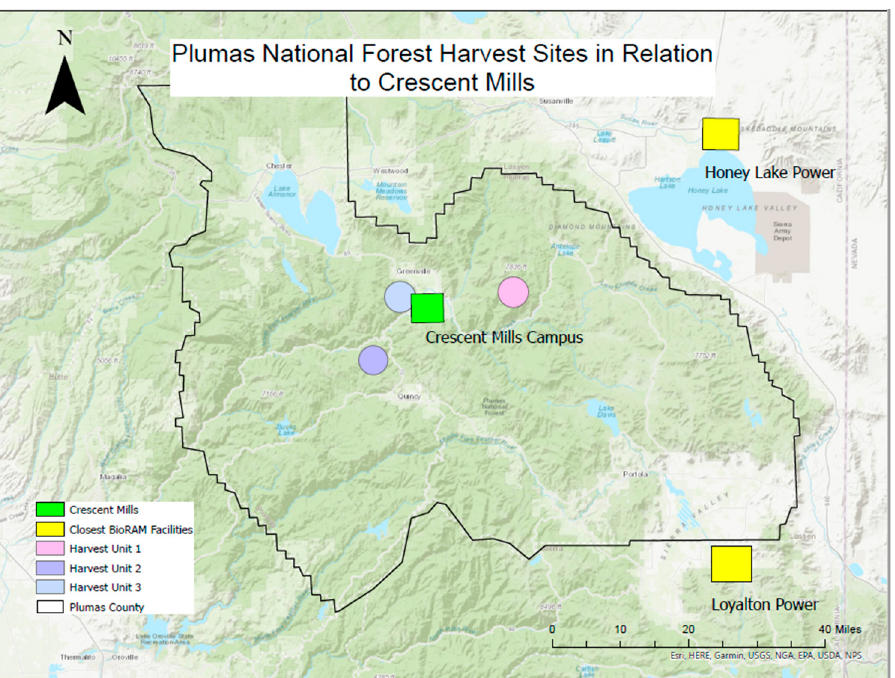
Figure 3. Harvest sites and eligible biomass power facilities around the Plumas National Forest in Northeastern